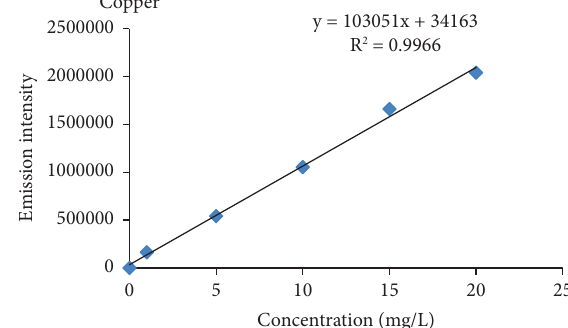
Figure 4: Standard calibration curve for copper.